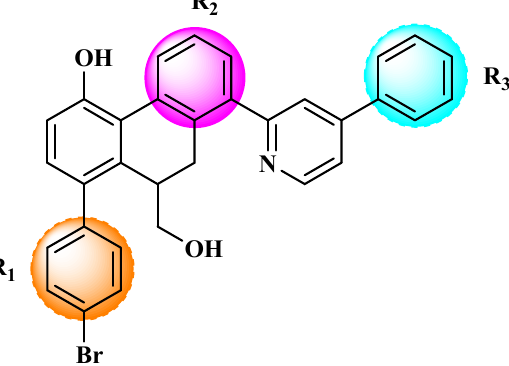
Figure 3. Chemical structures of the newly designed compounds.